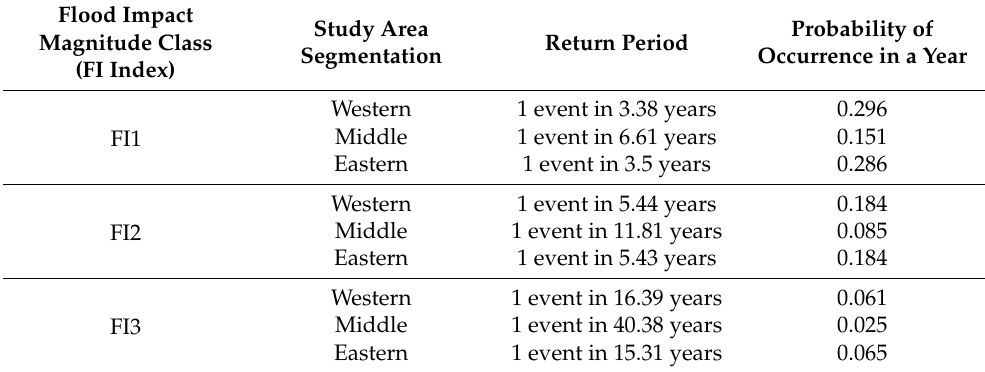
Table 5. Return periods of different categories of events (FI index) for three geographical